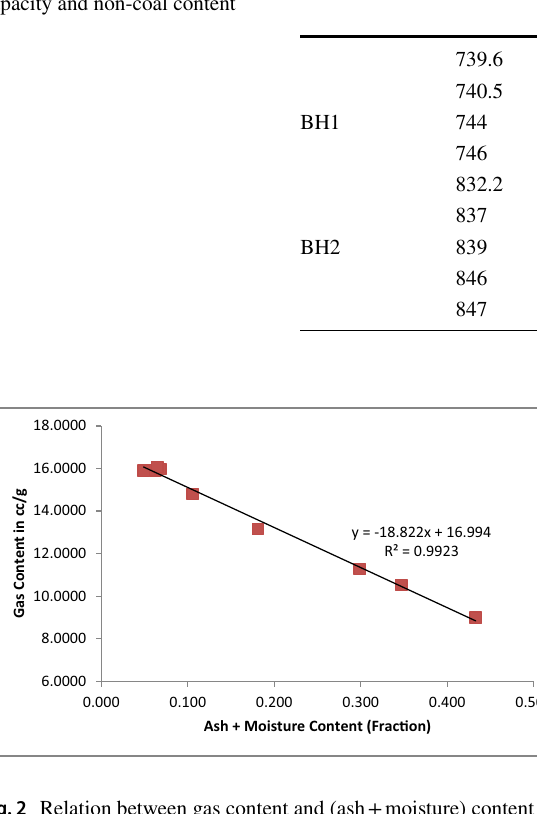
Fig. 2 Relation between gas content and (ash + moisture)